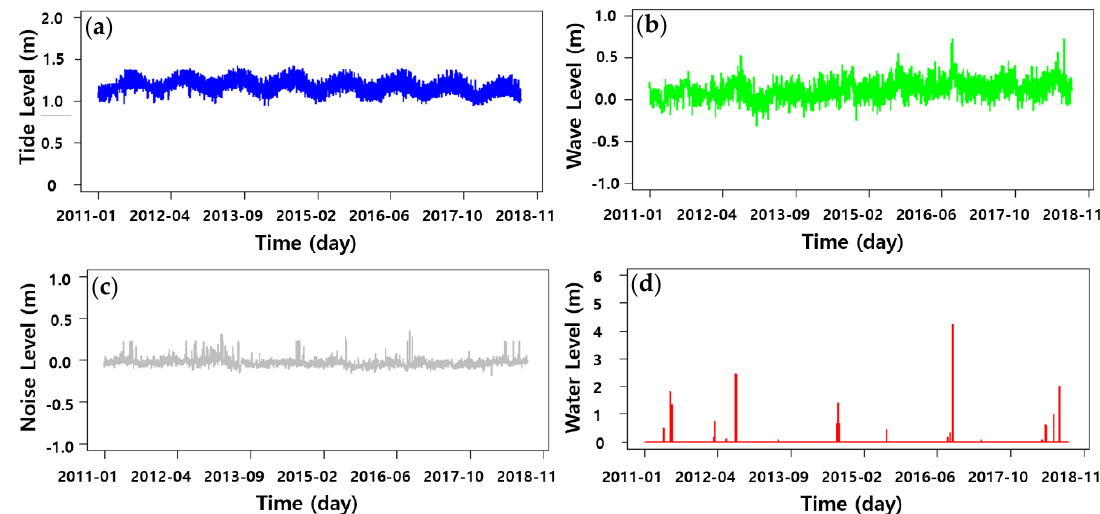
Figure 4. Decomposed components from water level and sea level: ( a ) tide component, ( b ) wave component, ( c ) noise component, ( d ) rainfall-runoff component. Table 1. Basic statistics for the decomposed time series of water level from Ulsan station.